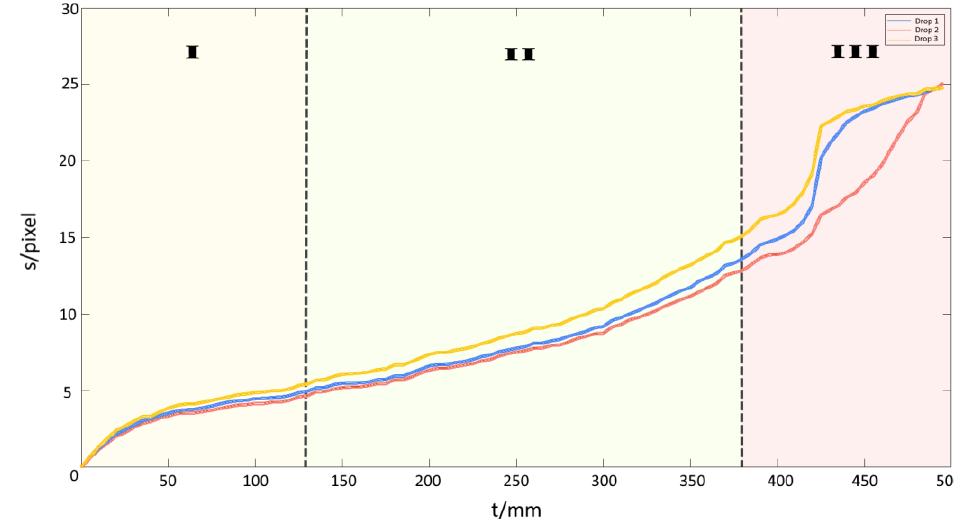
Figure 9. The three phases of the corrosion process (three samples given in red, blue and yellow curves). Phase I: Shows the saturation-like behaviour of interface diffusion. In this stage,